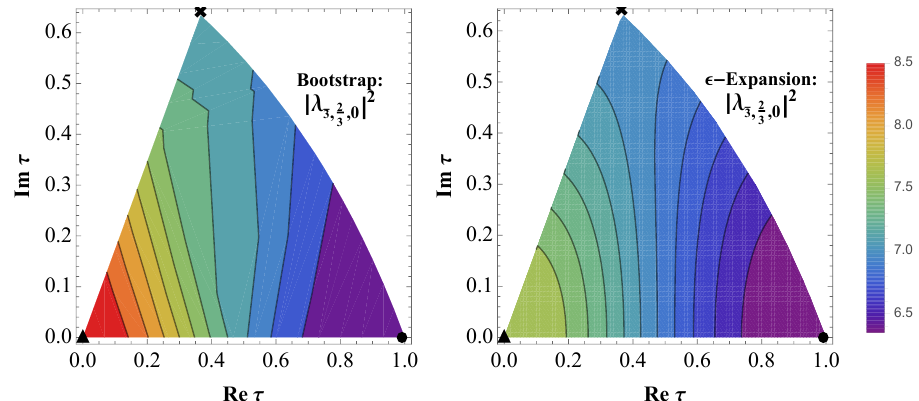
for all (cid:28) 6 1 ; 4 ; 0 3 p 3 ; 1 ; 0 for the Z 2 (cid:2) Z 2 , cWZ 3 ,